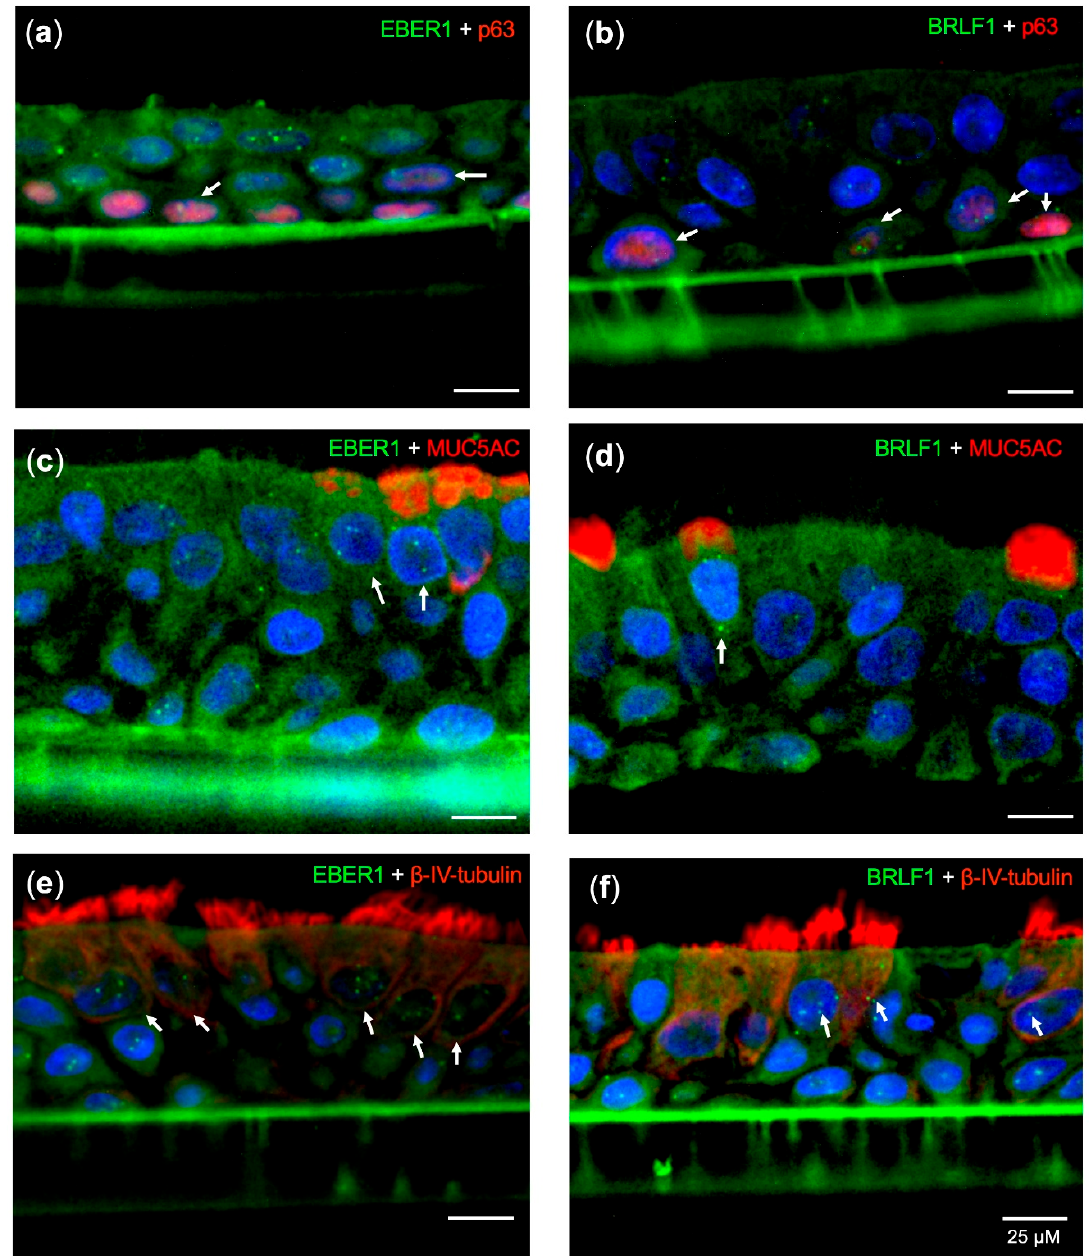
Figure 3. EBV infection of all cell types in the ALI culture. Longitudinal sections of EBV-infected transwells were assayed by immunohistochemistry of cell lineage markers and EBV-specific probes. ( a ) EBER1 and p63, ( b ) BRLF1 and p63, ( c ) EBER1 and MUC5AC, ( d ) BRLF1 and MUC5AC, ( e ) EBER1 and β IV-tubulin, and ( f ) BRLF1 and β IV-tubulin were stained, respectively. ISH signals of strong, discrete puncta in the nuclei are shown in green, and immunostaining signals are shown in red. White arrows indicate cells containing both green and red signals.